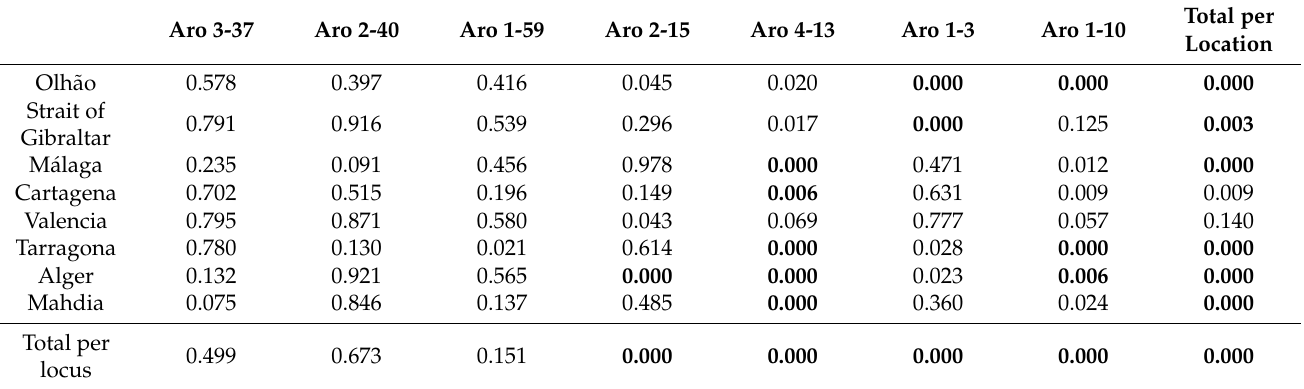
Table 4. Hardy–Weinberg equilibrium across locations for the 7 microsatellites loci. In bold, significant p -values after Bonferroni